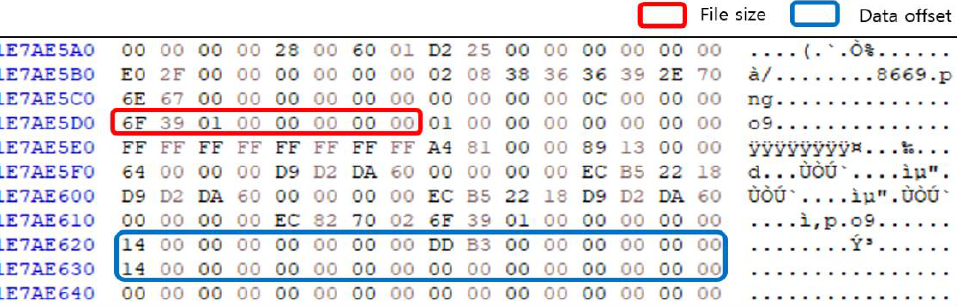
Figure 24. Records of the 8669.png file stored in snapshot format.